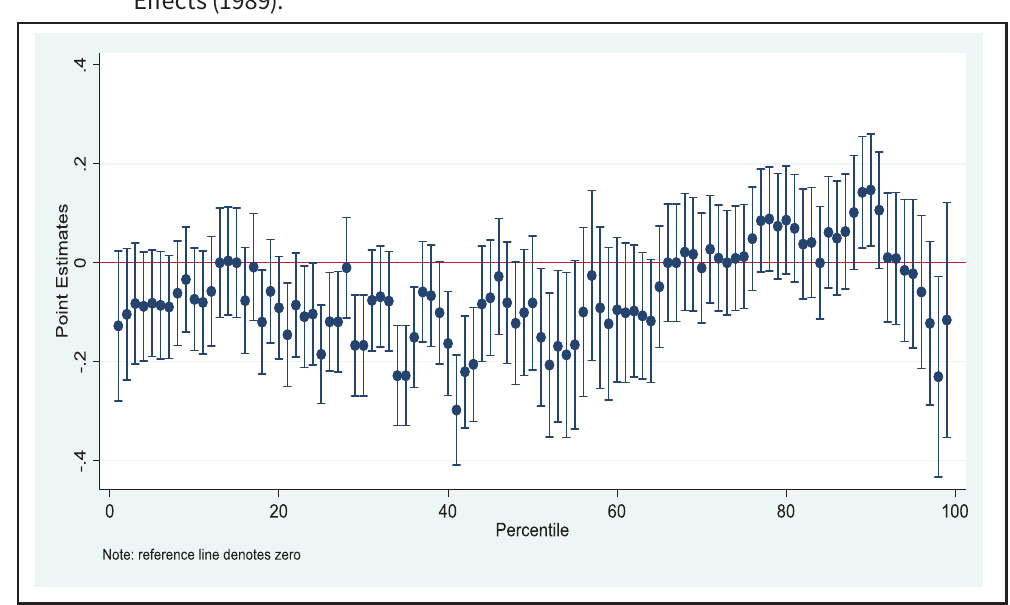
Figure 4 Point Estimates and 95% Confidence Intervals for Quantile Conflict Treatment Effects (1989).